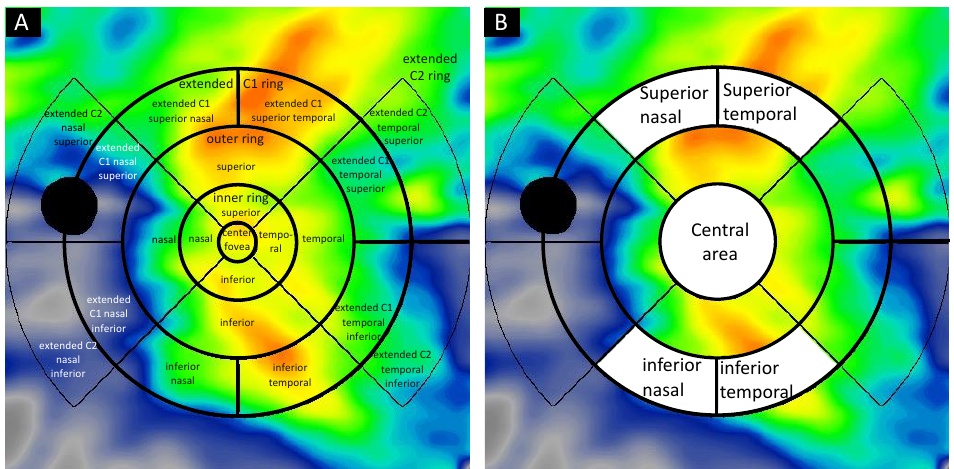
Figure 7. Images of choroidal volume map. ( A ) Shows the optical coherence tomography horizontal scan diagnosed chronic serous chorioretinopathy. ( B ) Shows the choroidal volume map in this case. ( C ) Shows each localization in which measurements were done. ( C-1 – C-11 ) Show the choroidal-scleral interface by scan from top to bottom in the image, cor- responding to each line drown in ( C ). It is segmented correctly. The color map display ranges from 0 to 800 microns. The arrows show the subretinal fluid.